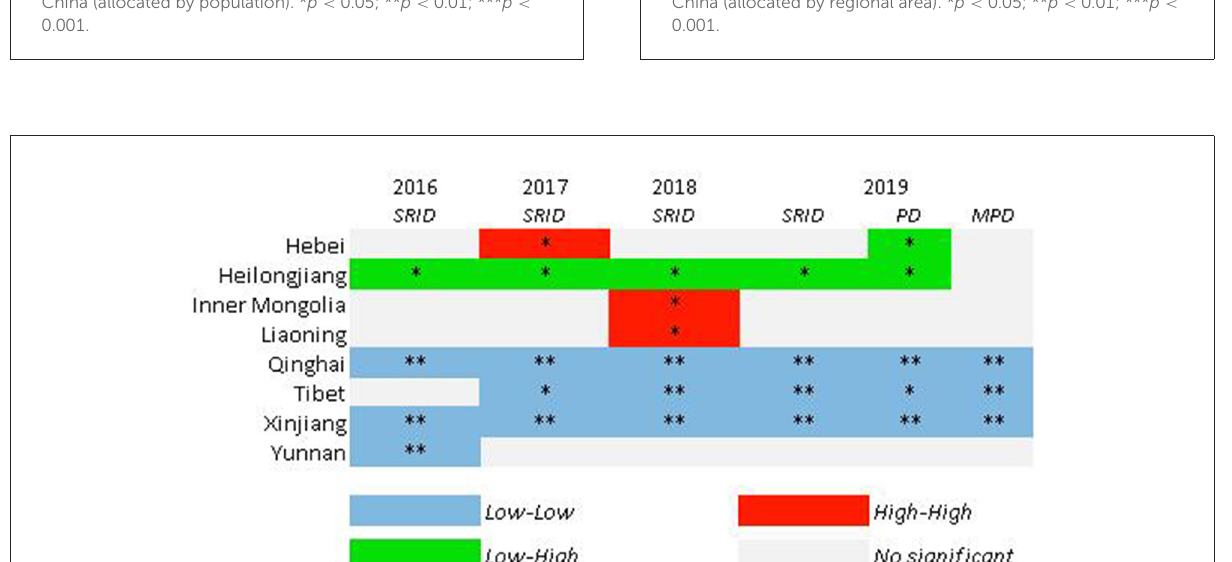
FIGURE3 The changes in Global Moran’s I index from 2016 to 2019 in China (allocated by regional area). * p < 0.05; ** p < 0.01; *** p < 0.001.